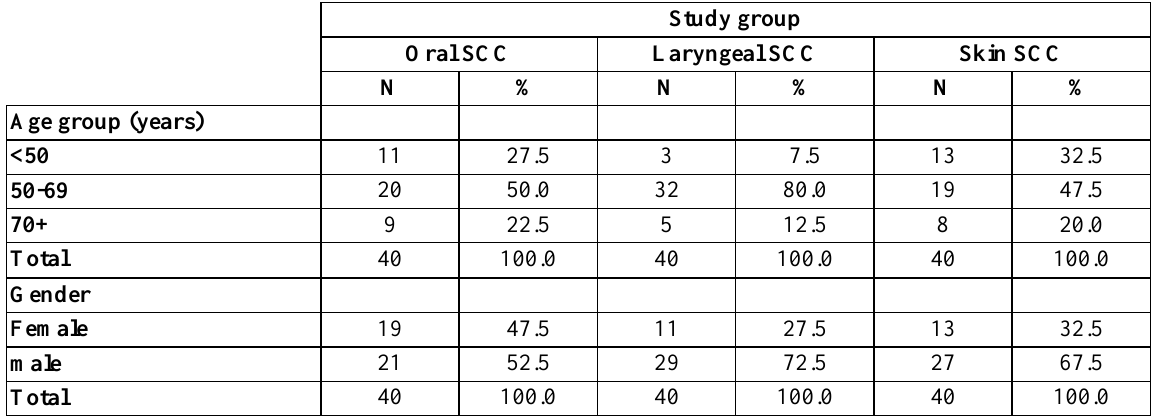
Table 1: Frequency distribution of the 3 study groups by age and gender.